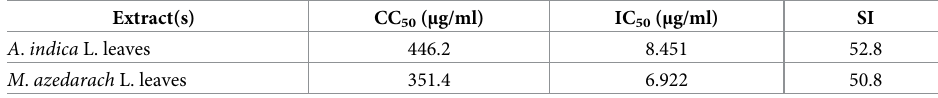
Table 2. Selectivity indices (SI) of the tested extracts.